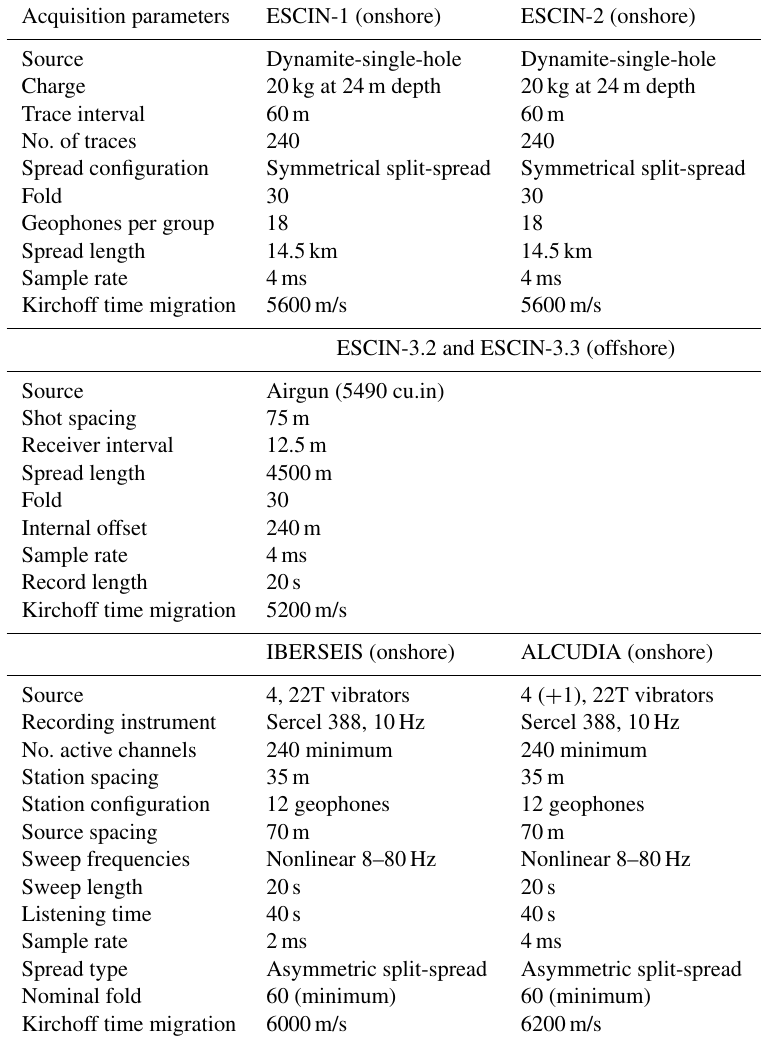
Table 1. Acquisition parameters of the NI seismic profiles shown in Figs 3–8 and the former processing flows. These are grouped according to their